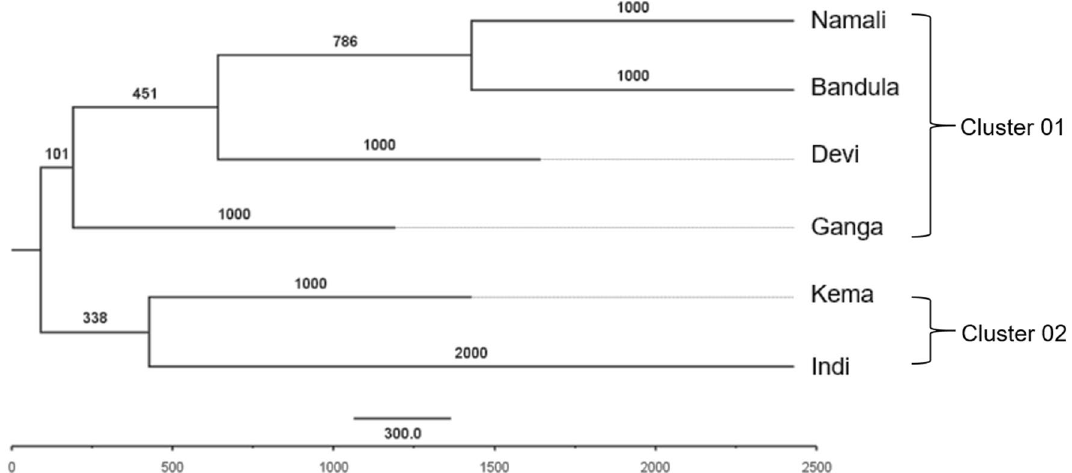
Figure 1. Relationship among Asian elephants in the National Zoological Garden, Sri Lanka. The phylogenetic tree developed based on the binary data matrix obtained by reading distinctive peaks of fragment analysis data, using UPGMA method. Bootstrap probability values for 1000 bootstrap resamples are indicated at each